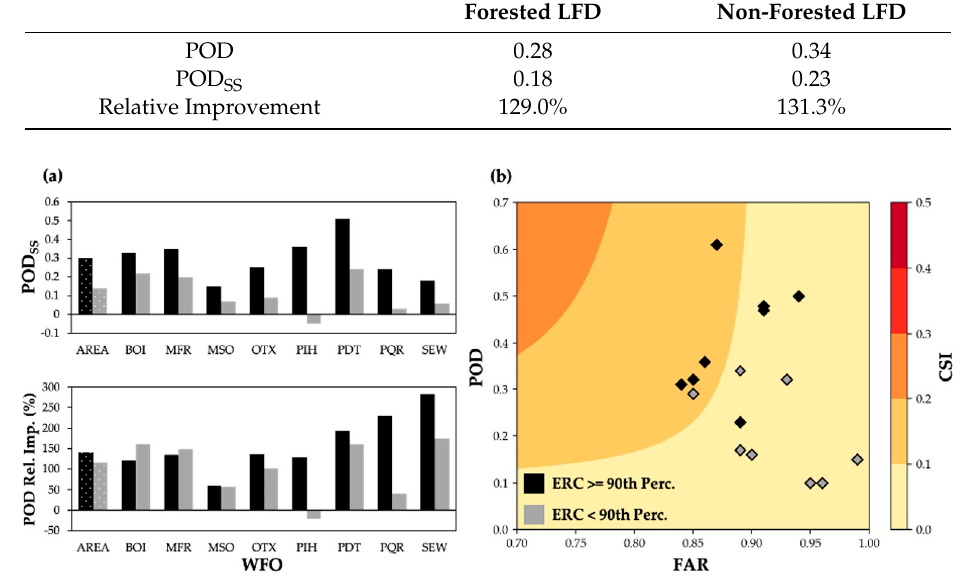
Figure 6. As in Figure 5, but for RFWs when large fire days occurred with ERC ≥ 90th percentile and ERC < 90th percentile values.